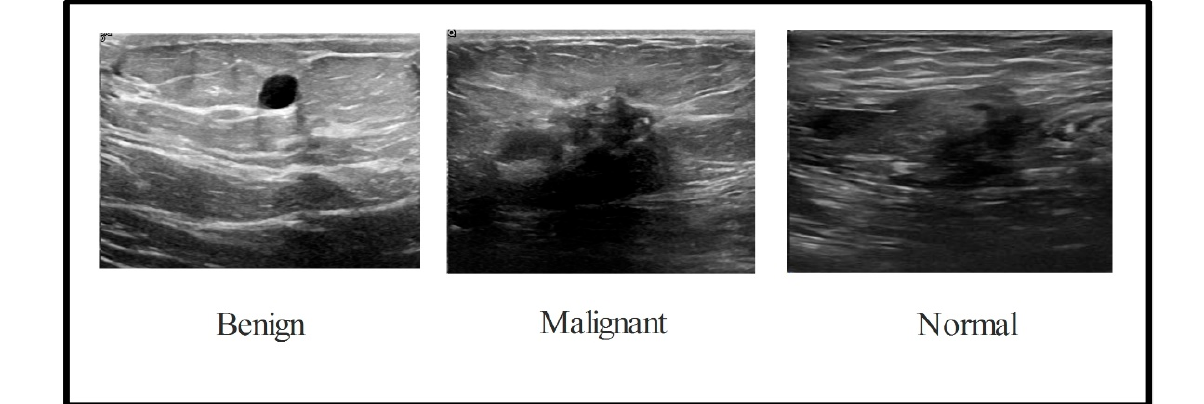
Figure 2. Sample ultrasound images of the BUSI dataset [59].